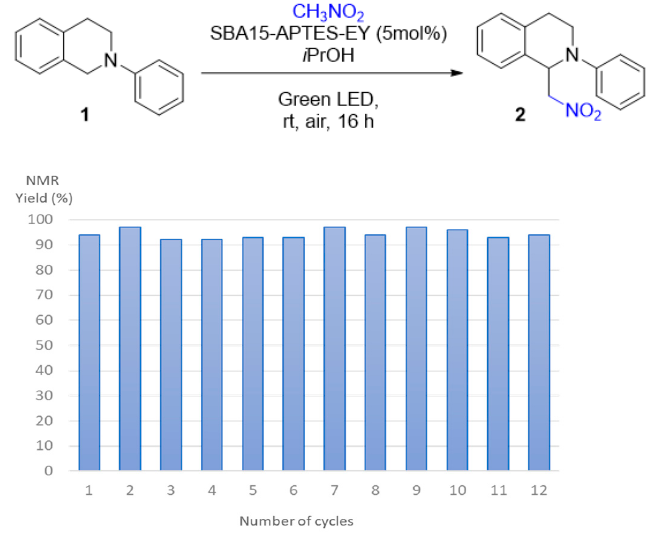
Figure 1. Photocatalyst recycling for aza-Henry reaction. 2.3. Impact of the Support on the Photoreductive Cyclization of Aryl Bis(Enones)